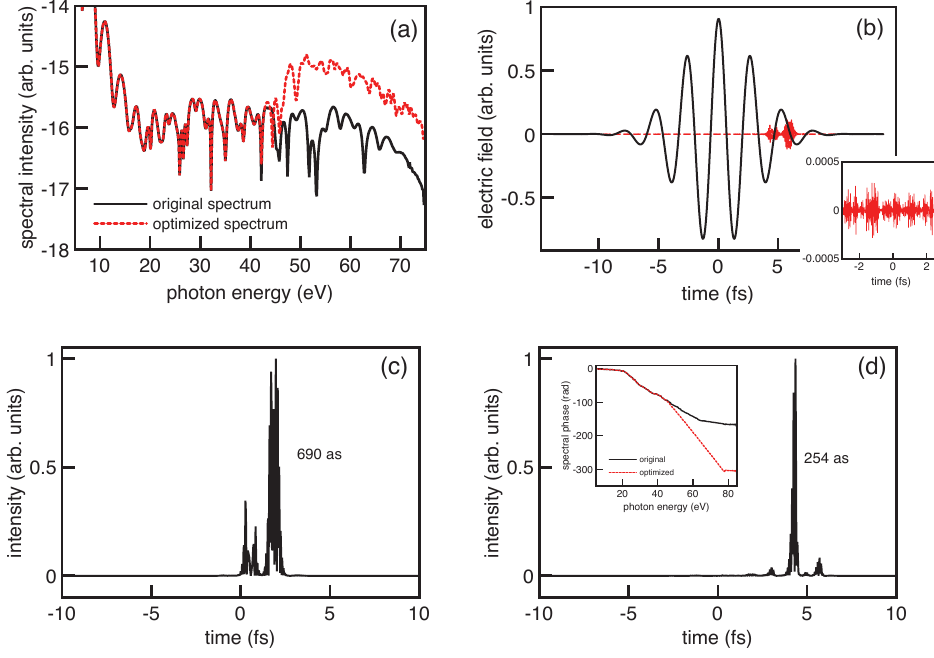
Figure 7. (Color online) Optimization of the HHG spectral region 50–70 eV obtained by considering a single feedback loop. The scan in (cid:18) is from (cid:18) = − 720 ◦ to (cid:18) = 720 ◦ , and (cid:11) is scanned from (cid:11) = 10 7 to (cid:11) = 10 8 . The value of the normalized (cid:31) 2 function is 0.8771 for the original spectrum and 0.2309 for the optimized one. In ( a ) the spectral intensity of the original and optimized spectra are shown, as indicated. The IR driving pulse together with the optimal XUV pulse are shown in ( b ). The amplitude of the IR pulse is normalized, and the one corresponding to the XUV pulse has been rescaled to allow its visualization. In this case the optimal values of the fitness parameters are (cid:11) = 10 8 and (cid:18) = 550 ◦ . ( c , d ) show the temporal evolution of the intensities of the XUV pulses resulting from the second interaction region, before and after optimization, respectively, which are centered at a photon energy of 60 eV. The inset in ( d ) shows the spectral phase for the original and optimized spectra. Note that the labels in the vertical axis of ( a ) indicate a logarithmic